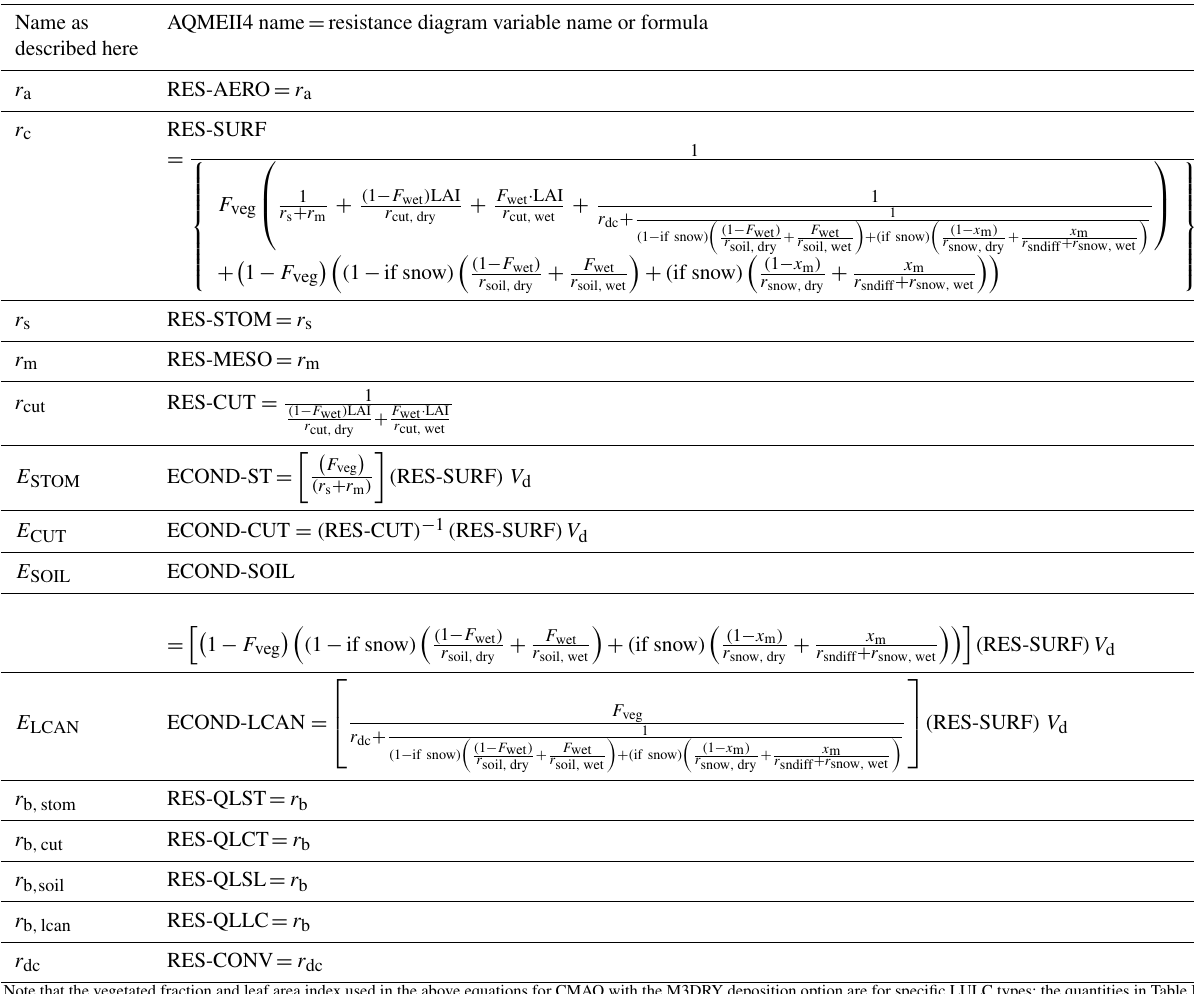
Table B2. AQMEII4-reported gaseous deposition variables corresponding to the CMAQ M3Dry resistance model of Fig. B2. Name